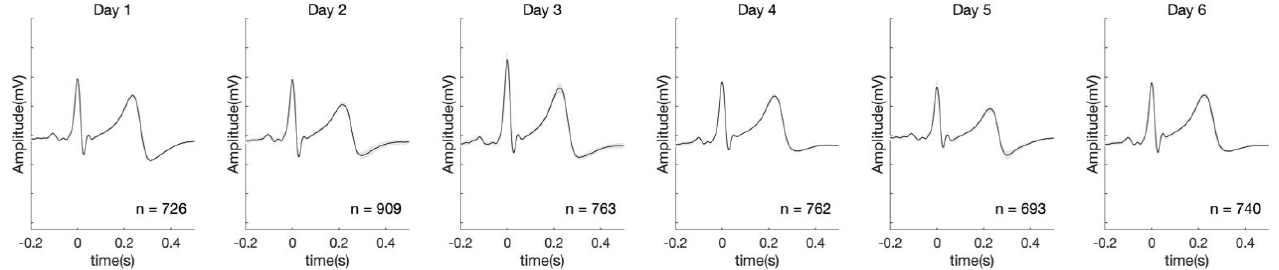
Figure 5. Synchronized average of ECG signals of the subject 10 for six days. The shaded areas represent the standard deviation in the signals.